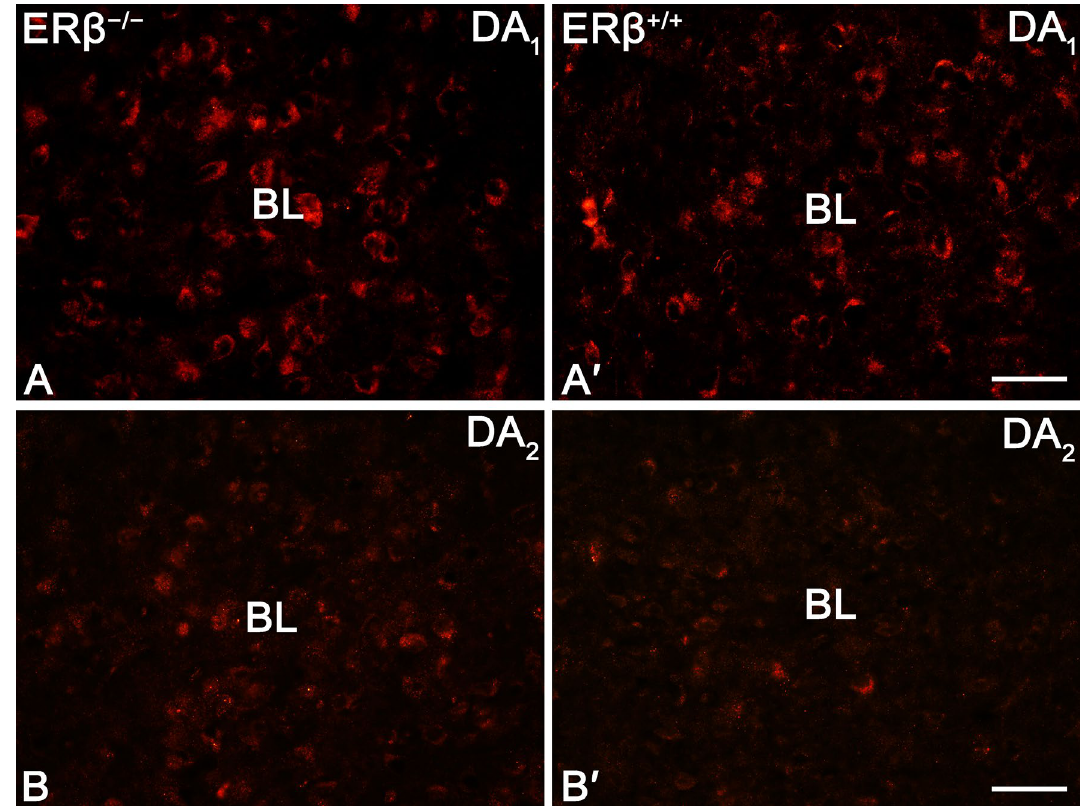
Figure 4. Representative colour photomicrographs illustrating the staining patterns of dopamine D 1 -like receptor (DA 1 ) and dopamine D 2 -like receptor (DA 2 ) in the amygdala basolateral nucleus (BL) of ERβ knock- out (ERβ −/− ) and wild-type (ERβ +/+ ) mice, n = 6 per group. ( A , B ) ERβ −/− mice. ( A ′ , B ′ ) ERβ +/+ mice. Note a lack of differences in DA 1 density between ERβ −/− mice ( A ) and ERβ +/+ littermates ( A ′ ). Note also increased density of DA 2 in ERβ −/− mice ( B ) when compared to ERβ +/+ littermates ( B ′ ). The scale bar applies to all microphotographs, and it corresponds to the length of 50